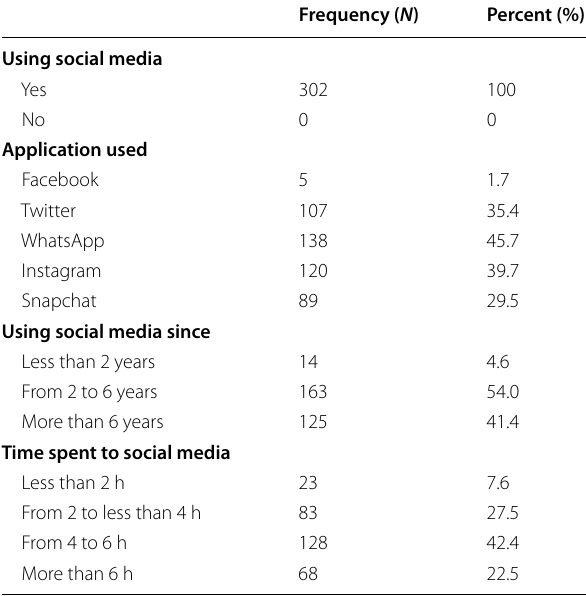
Table 2 Social media usage of the